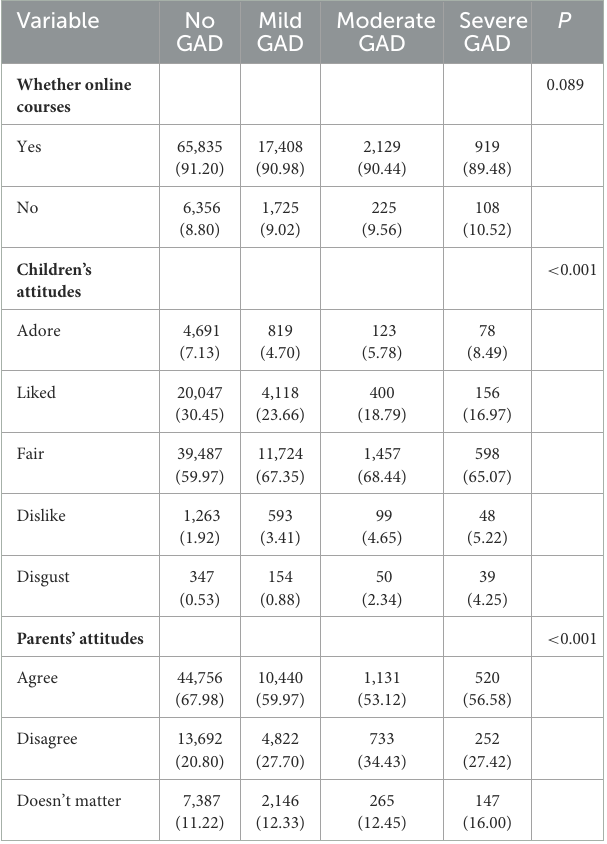
TABLE 3 The impact of children’s online classes on the anxiety of